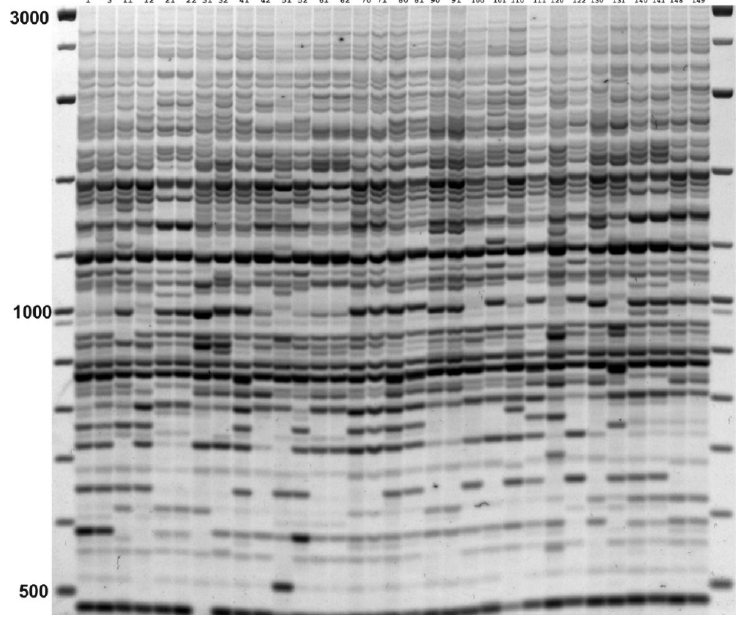
Figure 3. An IRAP gel produced with primer 2108 ( Wilma ‐ Bagy 2 LTR). DNA samples of the WEW